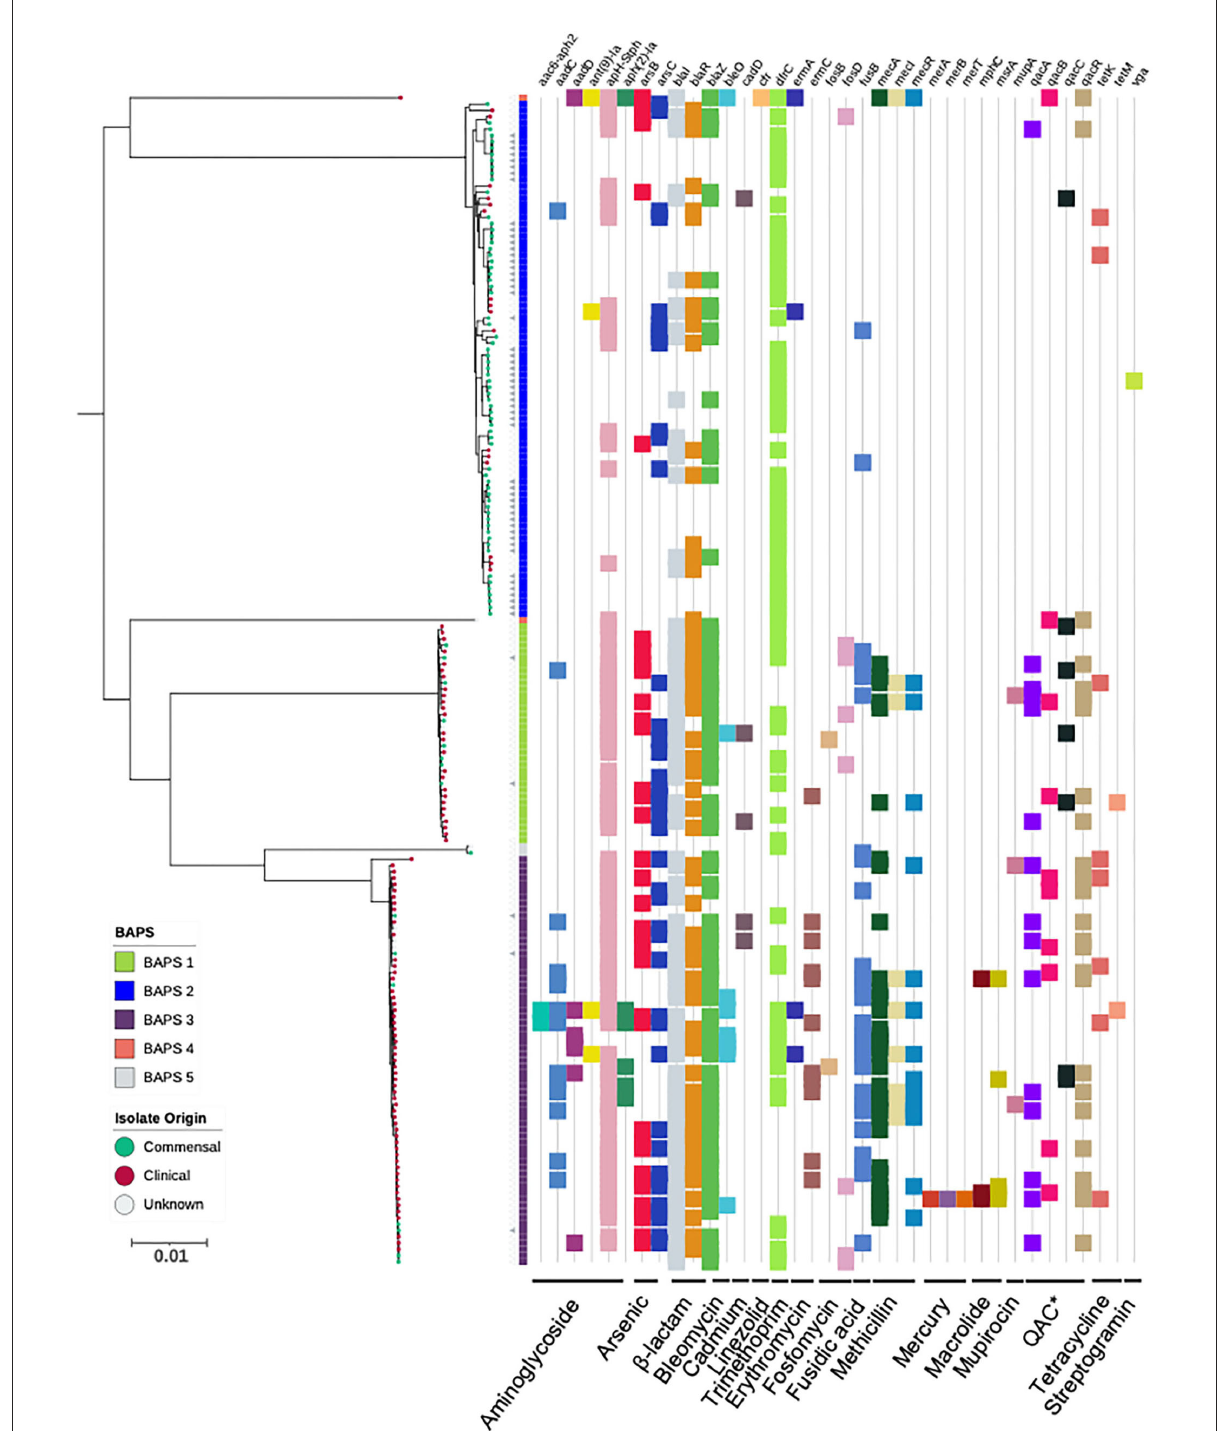
FIGURE2 Maximum-likelihood phylogeny based on core genome alignments of 186 S. capitis isolates, presenting the presence and absence of antimicrobial resistance genes. ML tree is midpoint rooted, and bootstrap support values were calculated from 1,000 replicates. The first color block represents rhierBAPS clustering, dots describe the setting where isolates were retrieved; green = commensal (including scalp samples from this study), red = clinical, and gray = unknown. Filled gray triangles describe scalp isolates from this study. The subspecies differentiation of S. capitis is presented as the subclades described as BAPS groups 1, 3, 4, and 5. The presence (colored blocks) and absence (white blocks) of antimicrobial resistance is denoted for each isolate (*Quaternary Ammonium Compounds). The scale bar represents the number of nucleotide substitutions per site. The figure was visualized using iTol v 4.2 (Letunic and Bork,